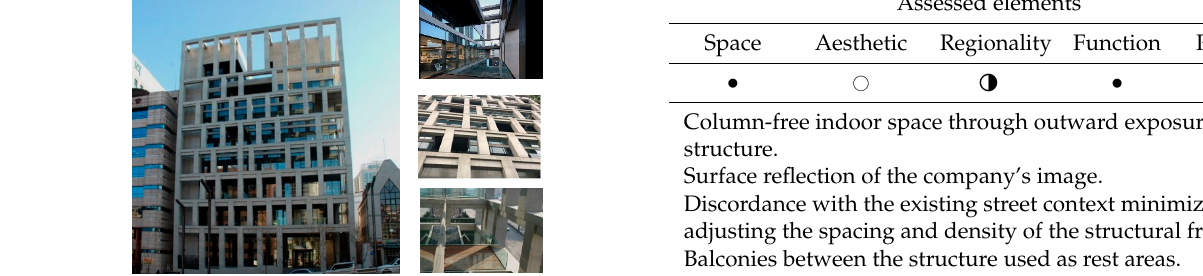
structure. Surface reflection of the company’s image. Discordance with the existing street context minimized by adjusting the spacing and density of the structural frame.